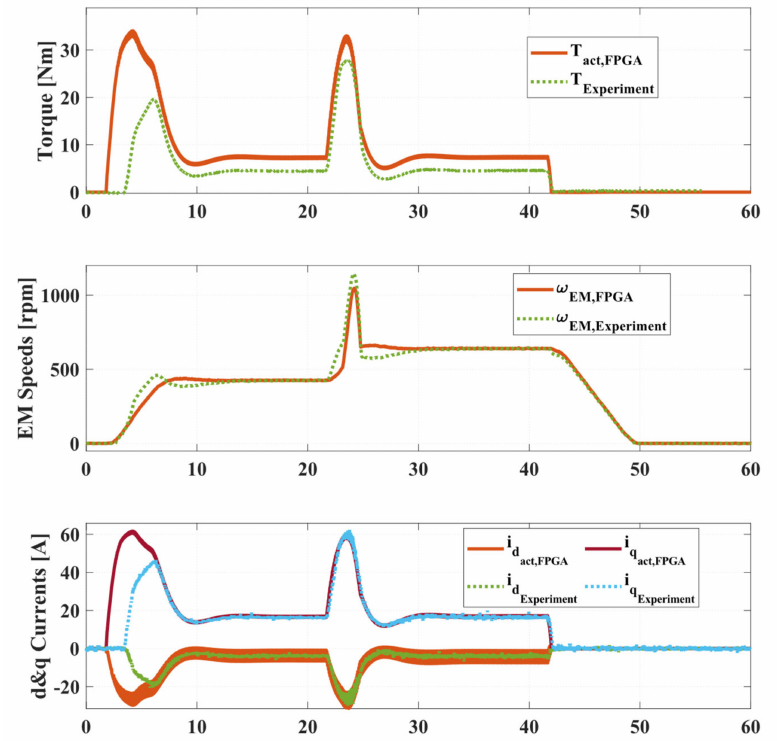
Figure 15. Comparation of electric machine performance between experiment and